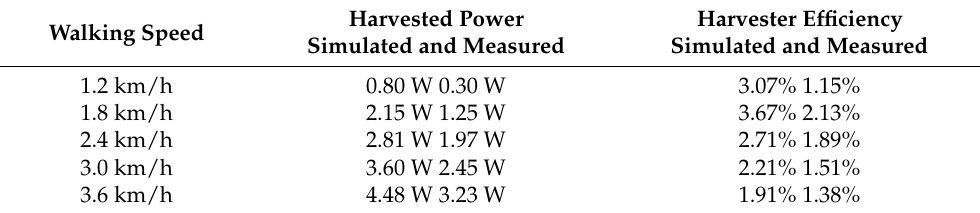
Table 4. Summary of the harvested power and efficiency at different walking